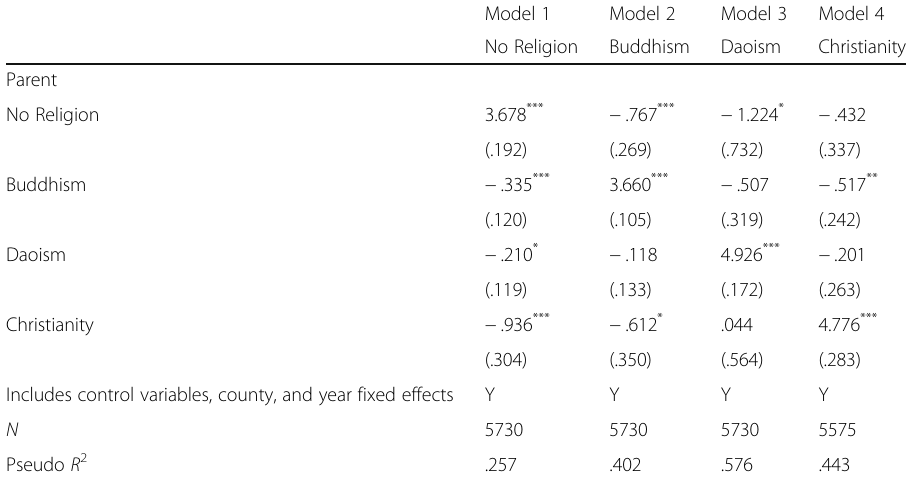
Table 7 Logistic coefficients regressing adult child ’ s religious affiliation on parent ’ s common religious